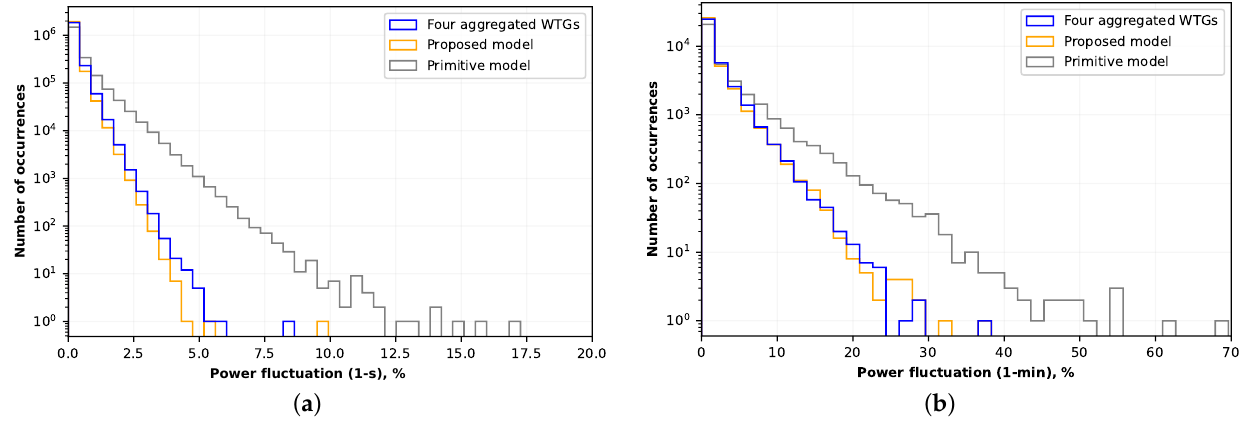
Figure 8. Histogram of percentage power fluctuations during May 2021 with four aggregated WTGs, the proposed WF model and primitive model. The power fluctuations are represented for ( a ) 1 s and ( b ) 1 min resolution